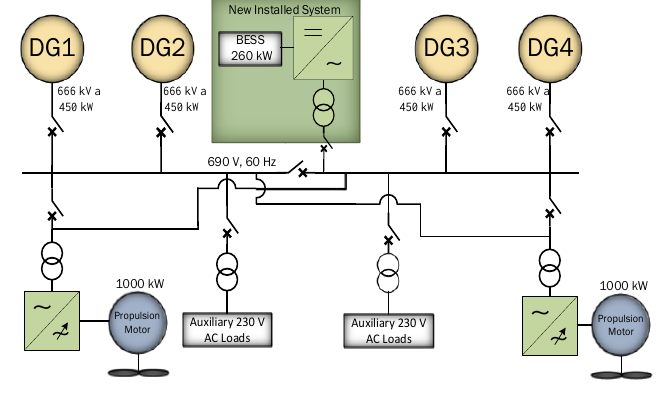
Figure 22. M/F Finnøy schematic